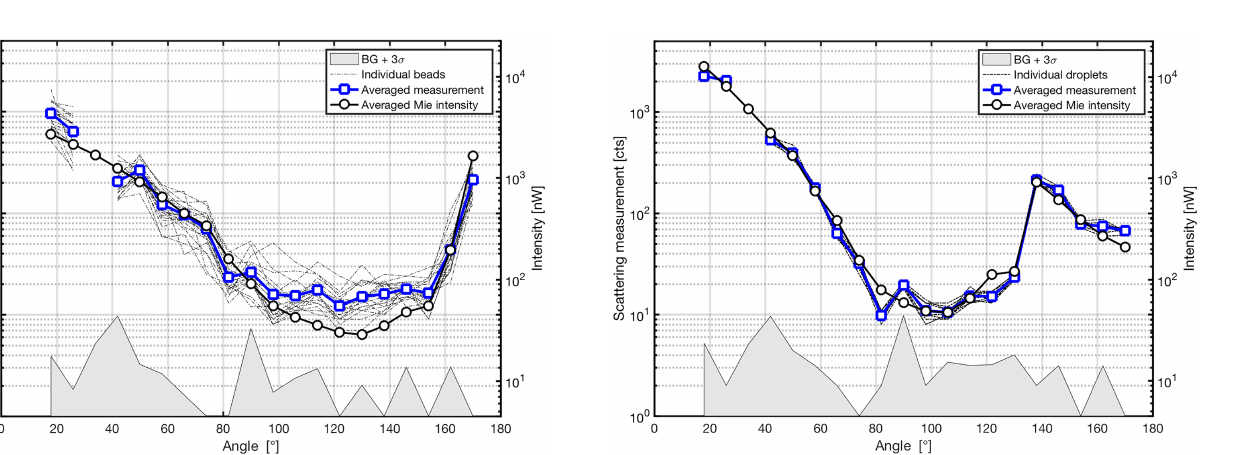
Figure 6. Characterization of the polar nephelometer using uni- formly sized single droplets from a piezo electric droplet